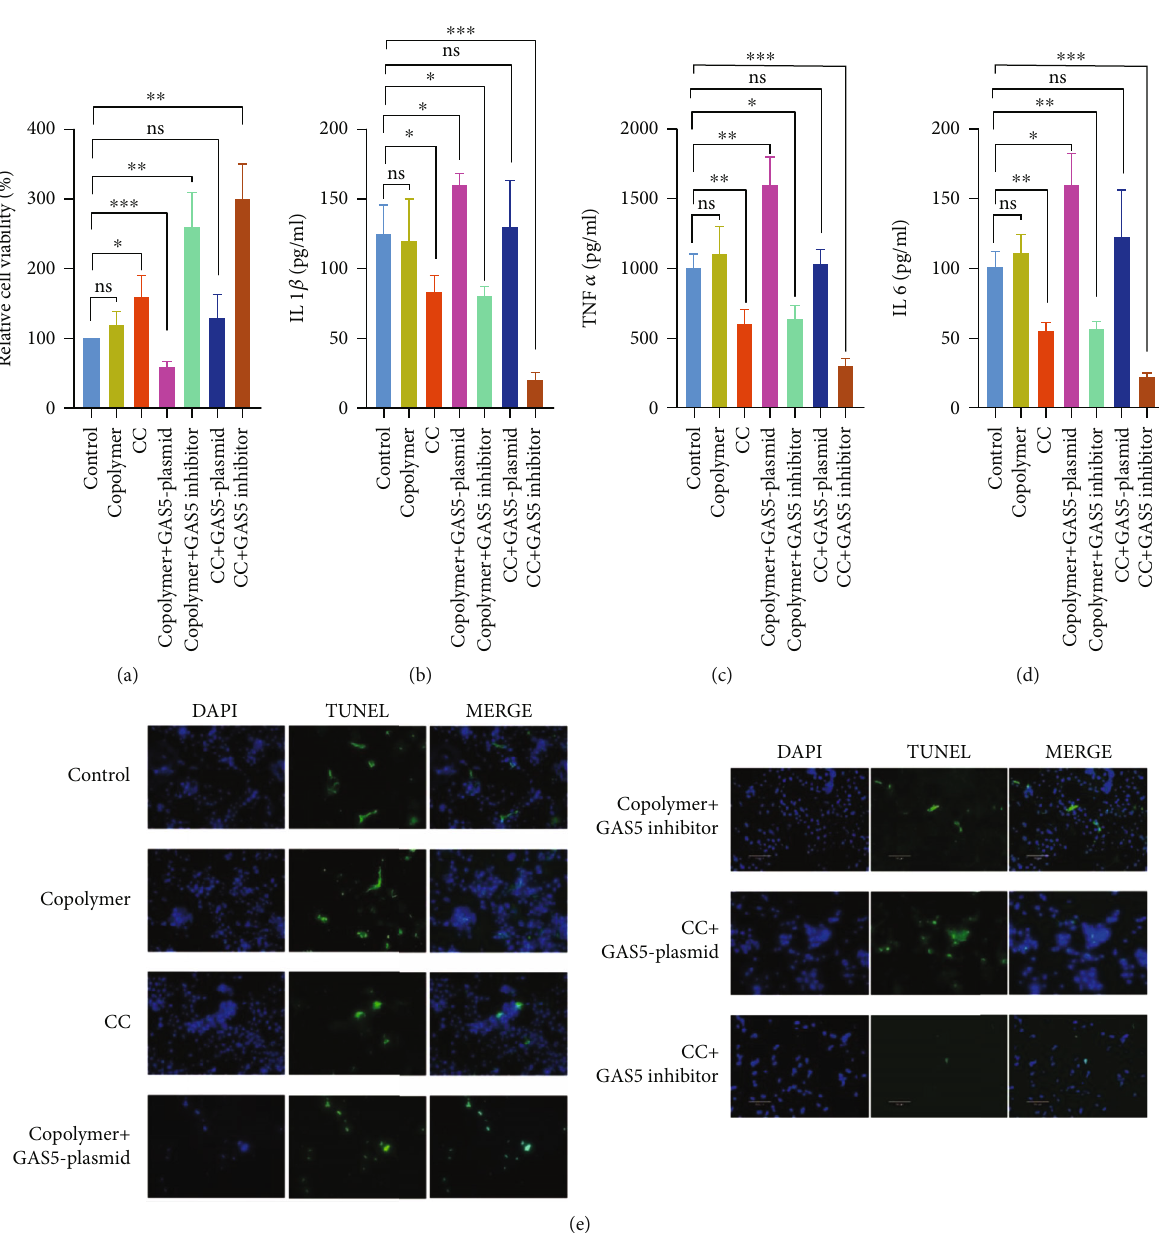
Figure 2: Cell viability and cytokine expression detections. (a) CCK-8 assay to detect cell activity. (b – d) The expression of cytokines IL-1 β (b), TNF- α (c), and IL-6 (d) at the cellular level. (e) TUNEL assay to detect cell apoptosis ( ∗ P < 0 : 05 , ∗∗ P < 0 : 01 , and ∗∗∗ P < 0 : 001 ; ns: not signi fi